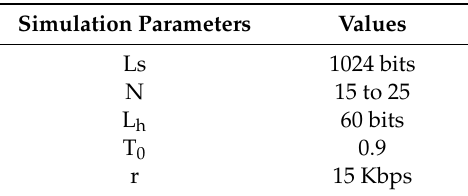
Table 3. Simulated Parameters.